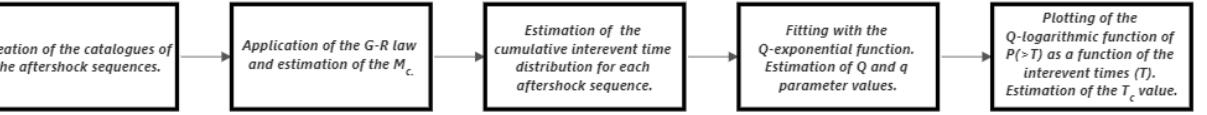
Figure 2. This flowchart summarizes the process behind the non-extensive statistical physics model implemented in the present